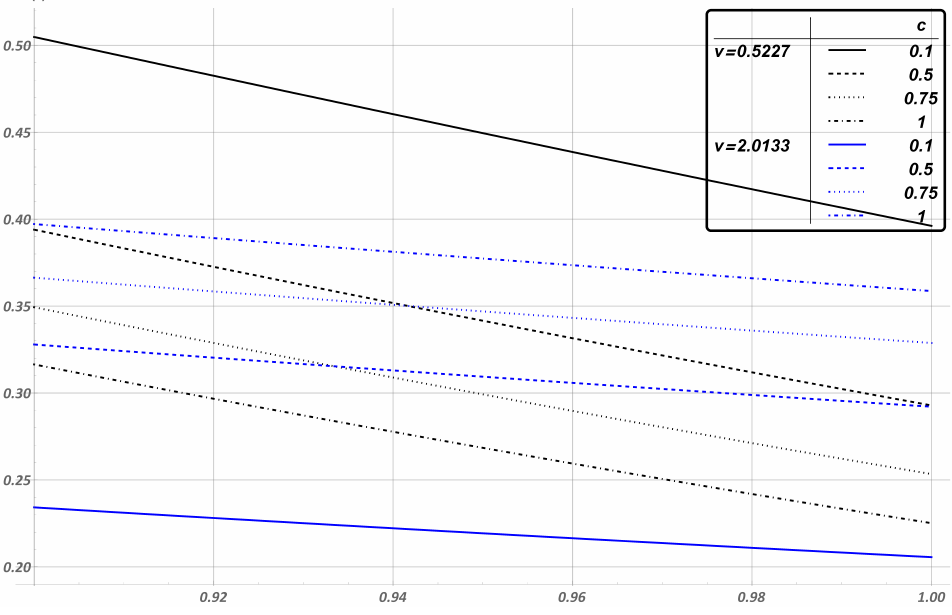
Figure 4. Reliability function on t =